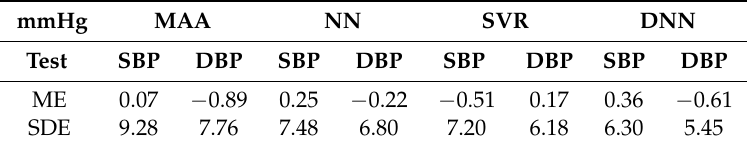
Table 5. Mean error (ME) and standard deviation of error (SDE) relative to the reference auscultatory method obtained with the conventional maximum amplitude algorithm (MAA) [1], neural networks (NN) [4], support vector regression (SVR) [14] and deep neural network’s (DNN) regression model [10], where the results are the average values for our test data.